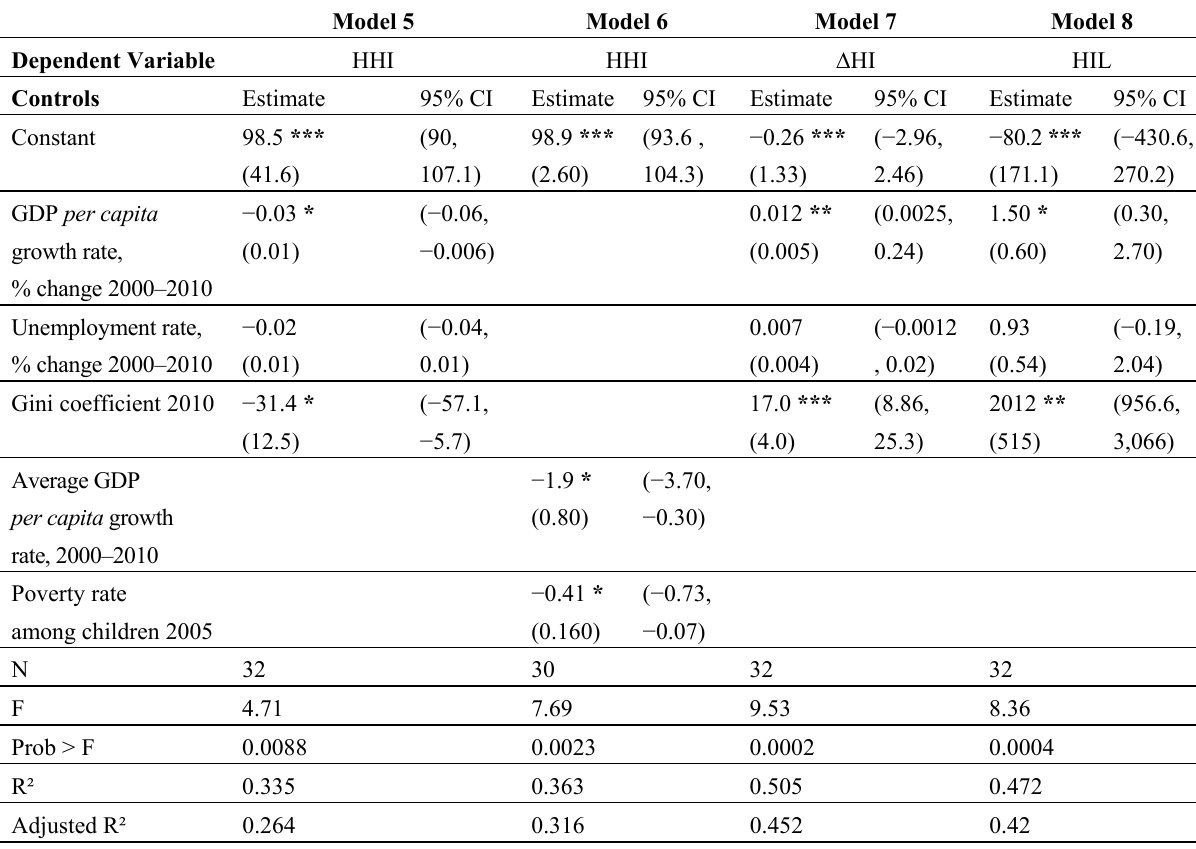
Table 3. Cross-sectional results: 2010-Health Index adjusted for Inequality